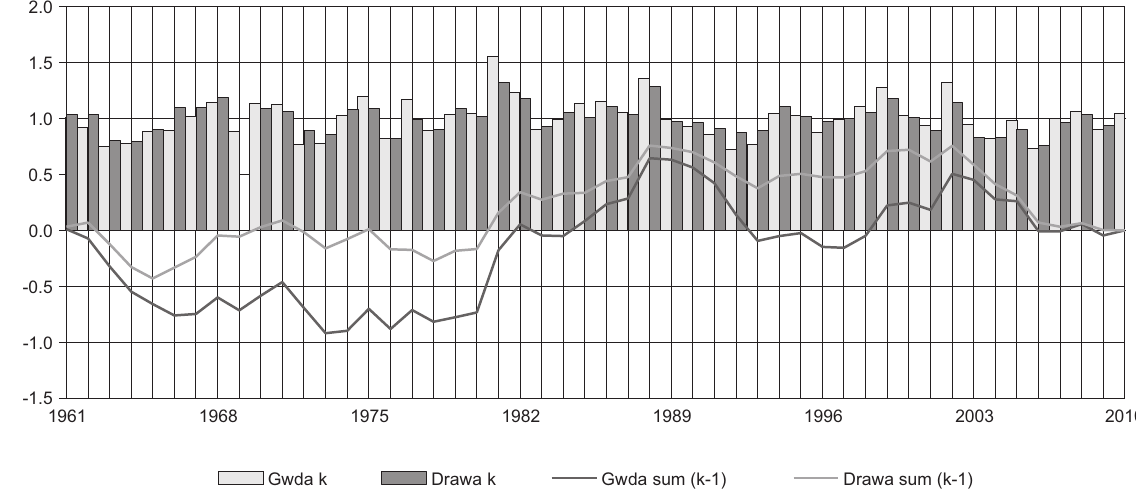
Fig. 7. Coefficient k and sum (k-1) for the Gwda River in Piła and the Drawa River in Drawiny in hydrological years